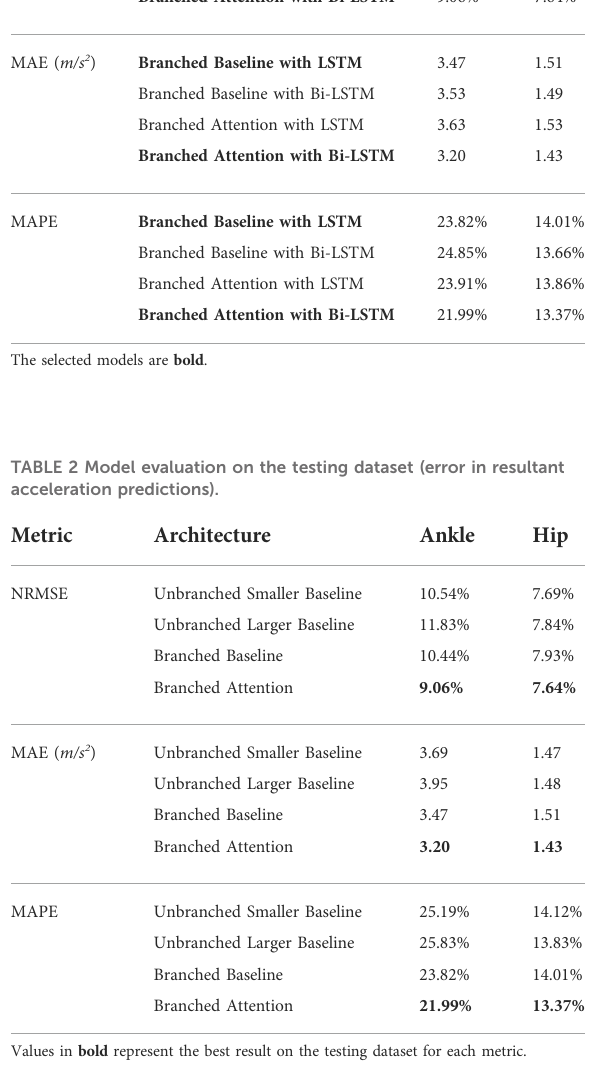
TABLE 1 The Comparison of Model Performance with LSTM/Bi-LSTM using testing data set. Metric